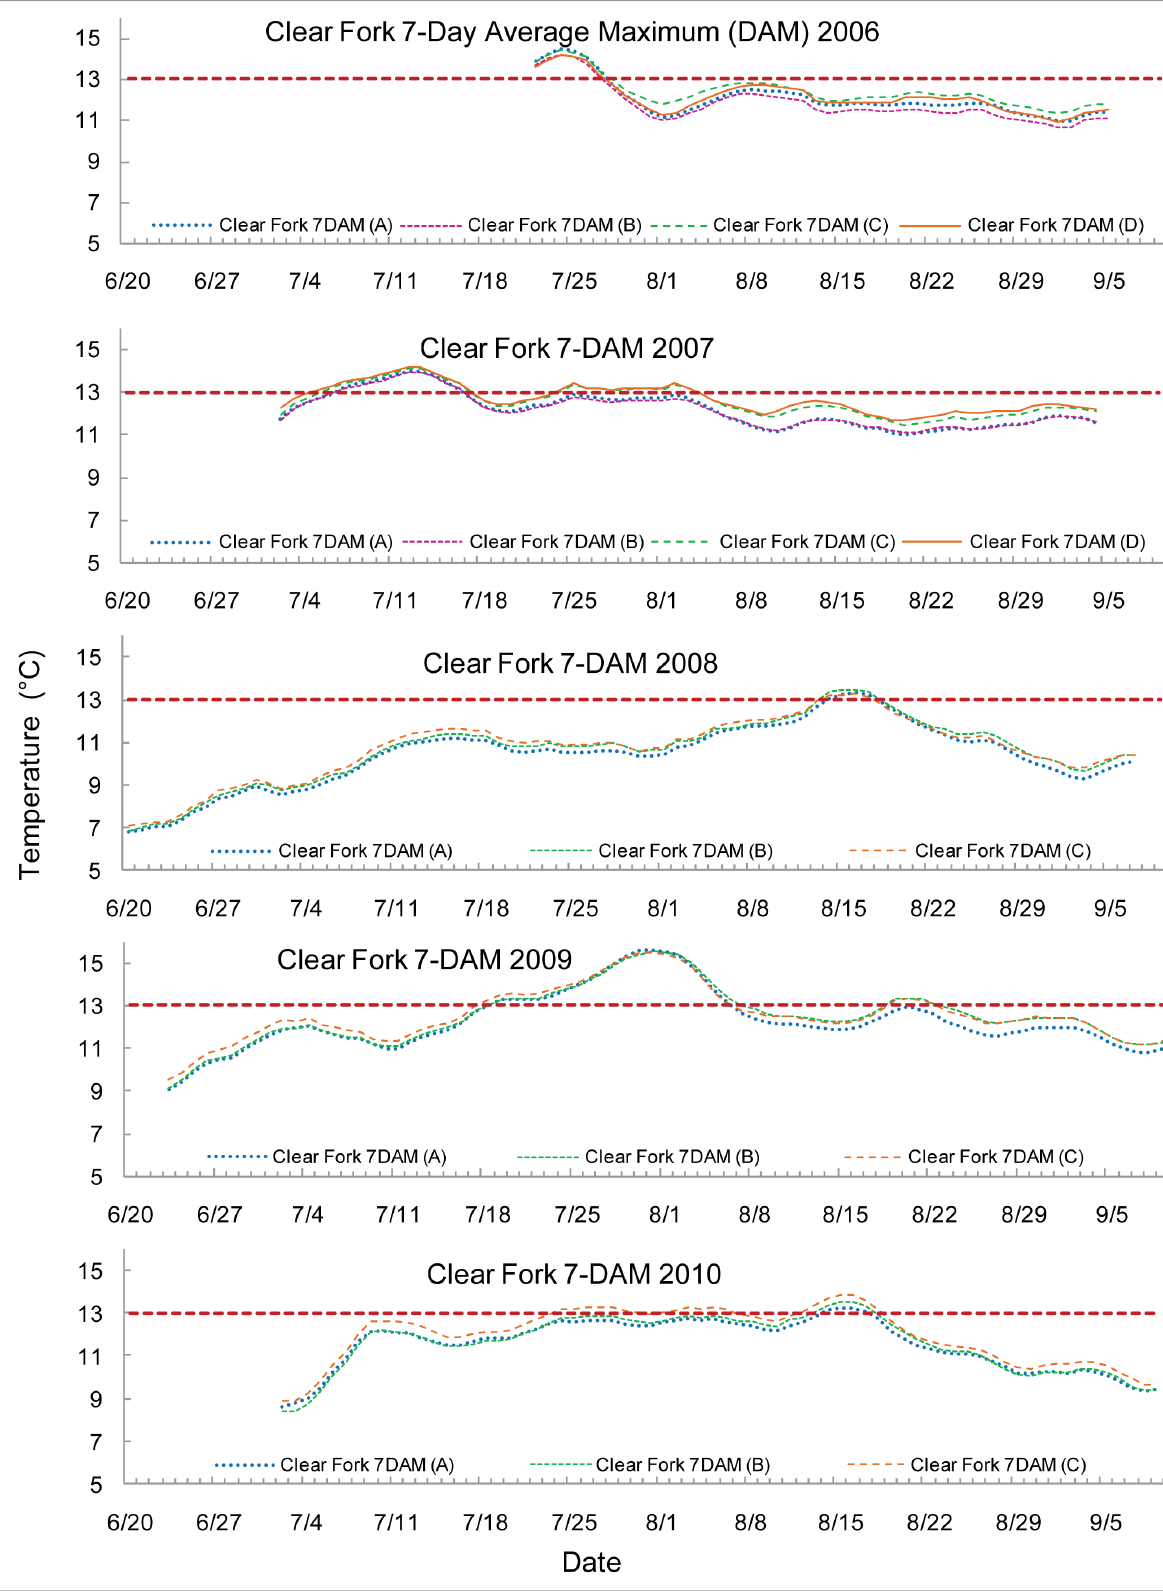
PLOS ONE | www.plosone.org